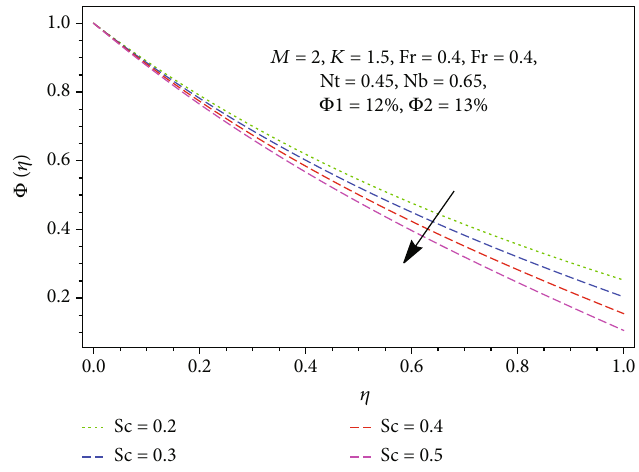
Figure 13: Impact of Schmidt number Sc on the concentration pro fi le ϕ ð η Þ .